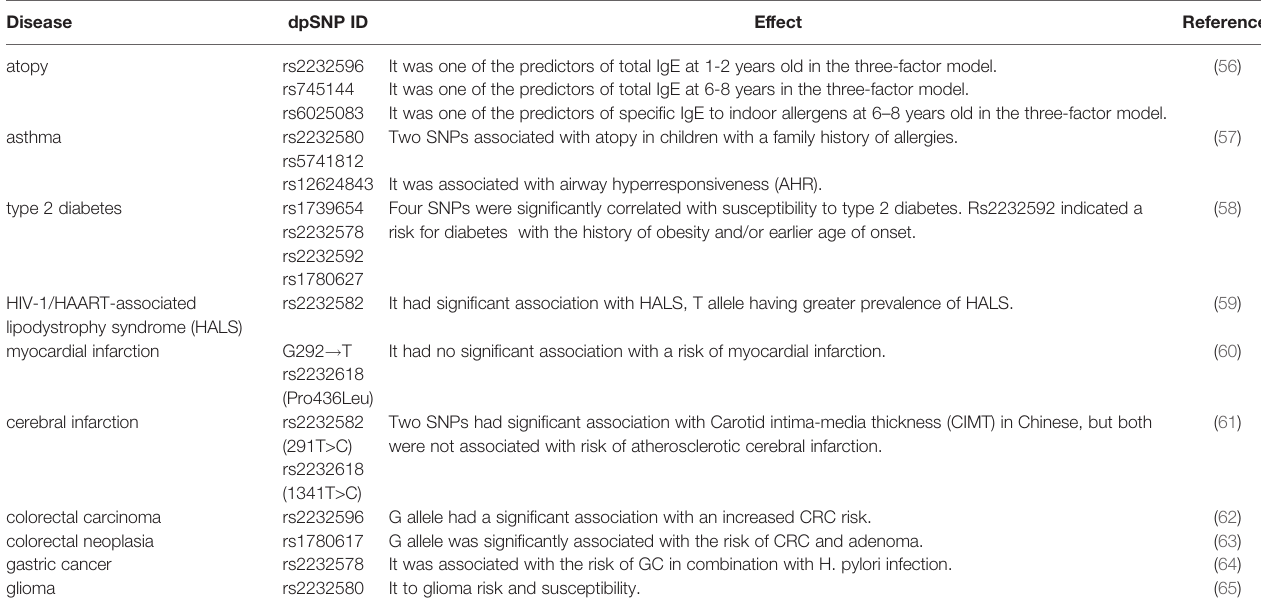
TABLE 2 | Effect of SNP in LBP-gene atopy, metabolic diseases and cancer.